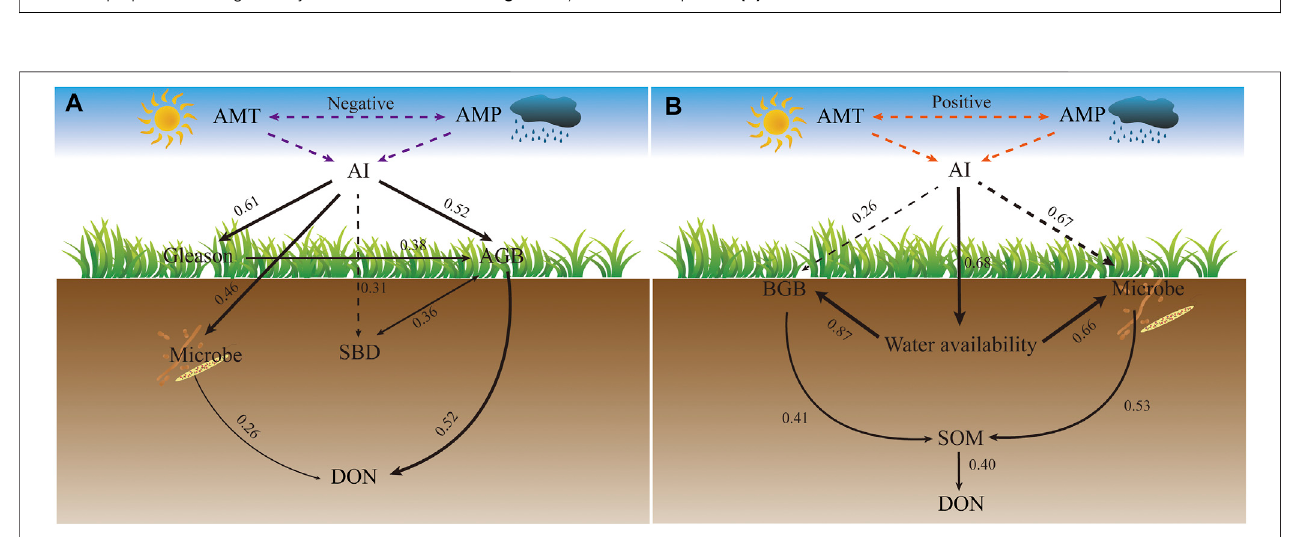
FIGURE4| Relativecontributionsofenvironmentalandbiologicalfactorstodissolvedorganicnitrogen(DON)(e.g.,climate,plant,soil,andmicrobialpropertiesthat signi fi cantly correlated with DON in Figure 3A ) in the LDON pattern (A) and relative contributions of environment and biological to DON (e.g., climate, plant, soil, and microbial properties that signi fi cantly correlated with DON in Figure 3B ) in the HDON pattern (B) .